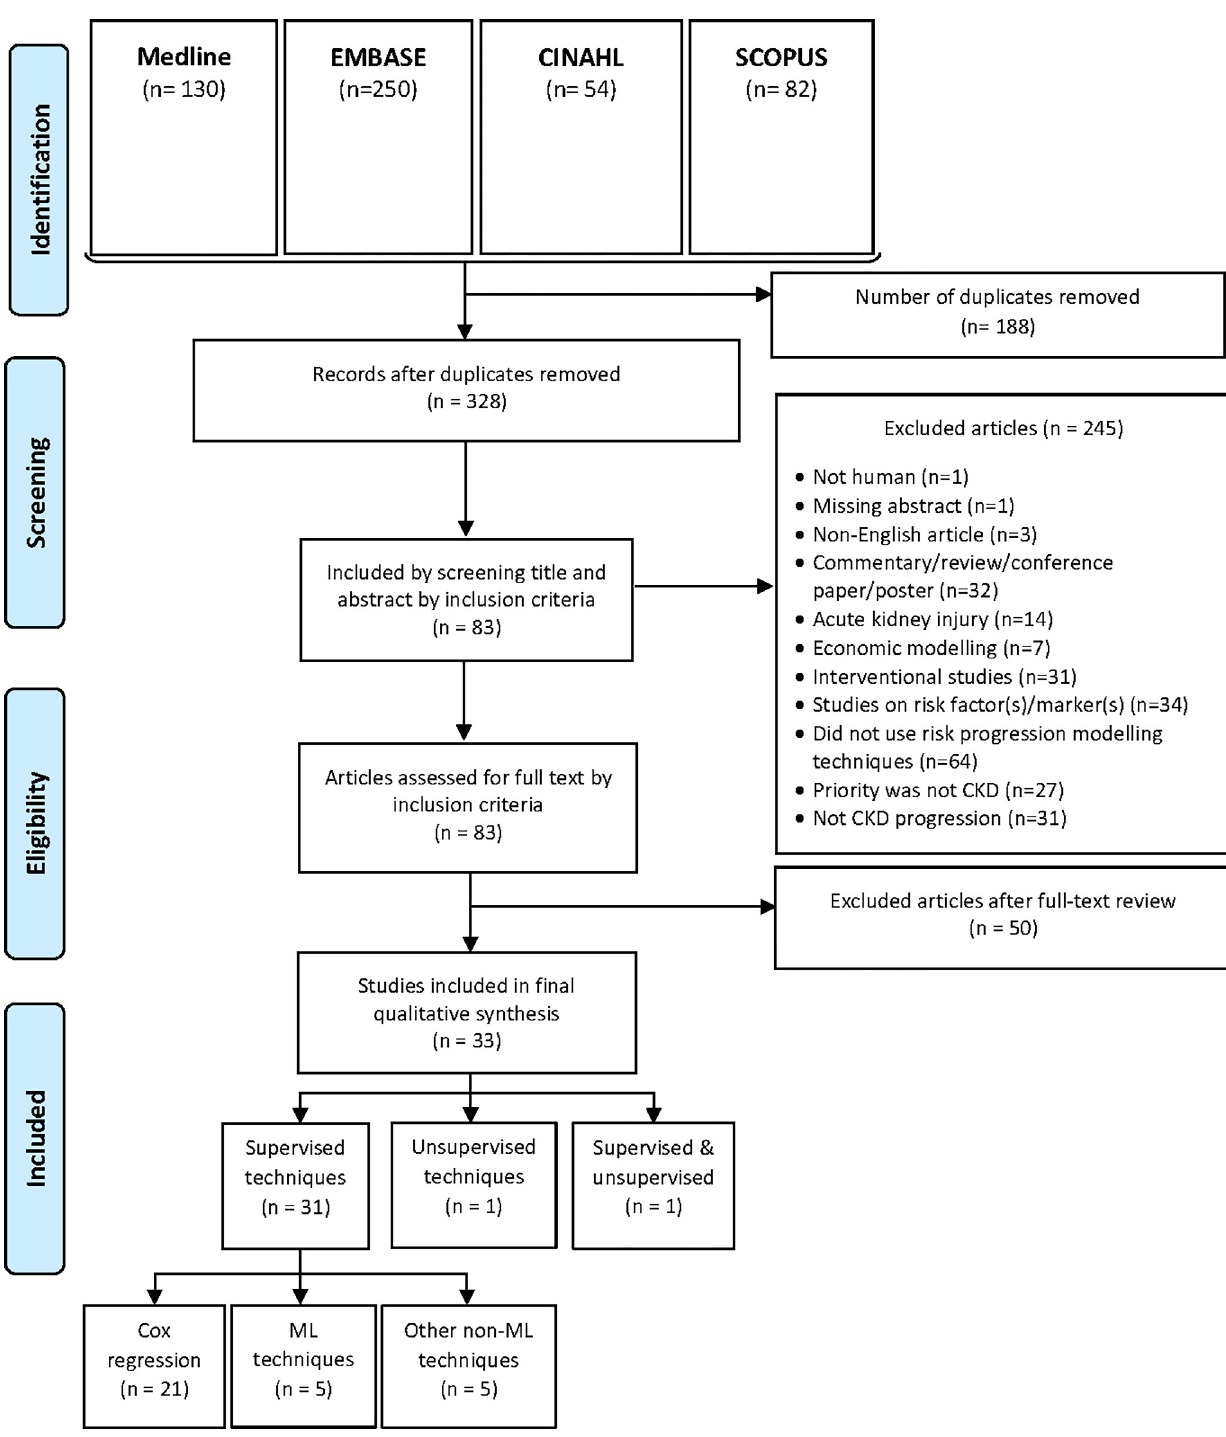
Fig 1. PRISMA flow